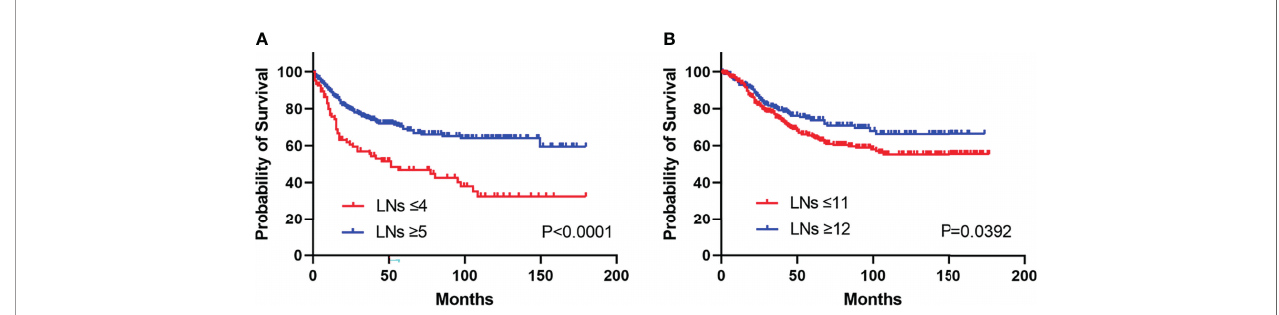
FIGURE 2 | Kaplan – Meier curves illustrate cancer-speci fi c survival strati fi ed by lymph node risk in patients with duodenal (HR: 0.39, 95% CI, 0.26 to 0.58, p < 0.0001) (A) and jejunoileal tumors (HR: 0.71, 95% CI, 0.52 to 0.98, p = 0.0392) (B) . LNs,